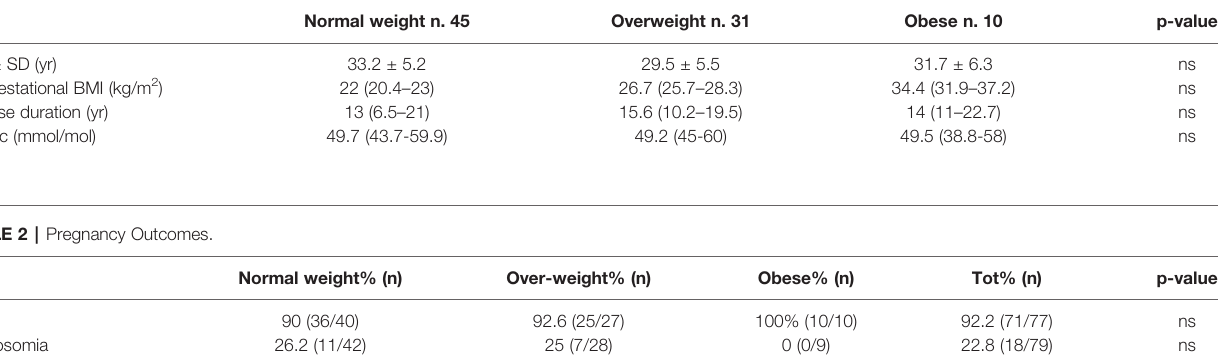
TABLE 1 | Main clinical characteristics.